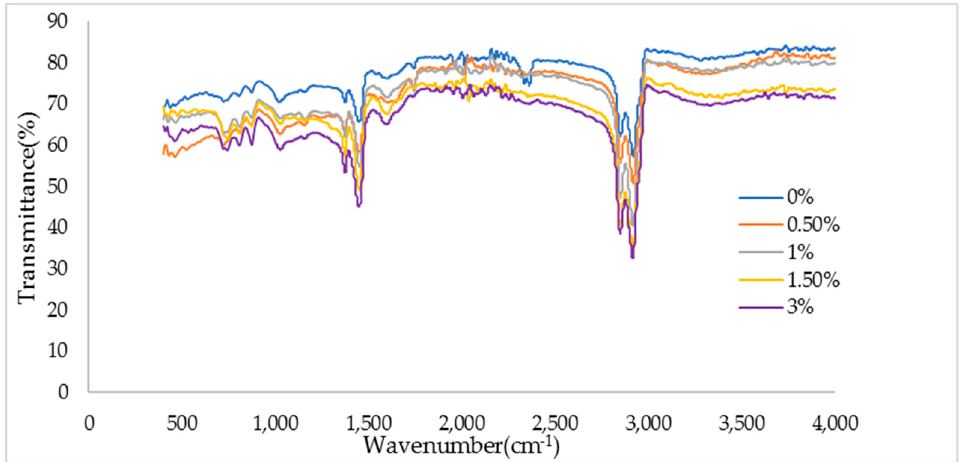
Figure 6. FTIR of unmodified and CNT-modified bitumen.